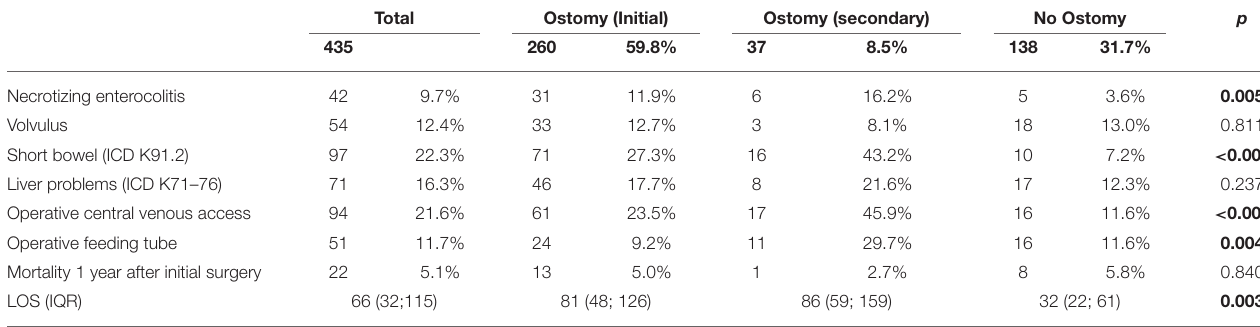
TABLE 3 | Comparison between patients with and without ostomy.